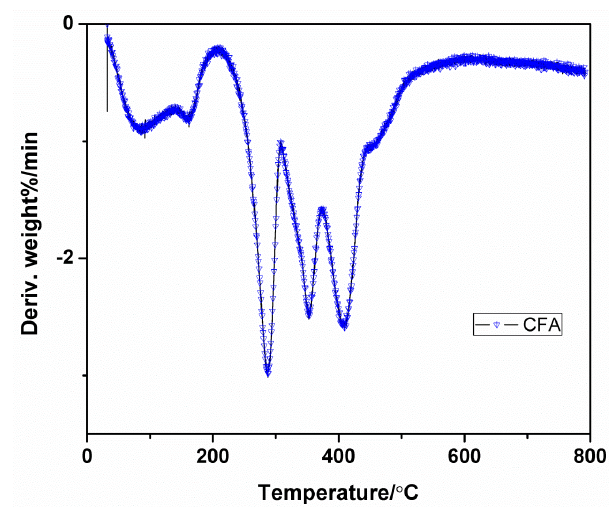
Figure 6. Di ff erential Thermal Analysis (DTG) curve of Figure 6 . Differential Thermal Analysis ( DTG) curve of CFA. Figure 6 . Differential Thermal Analysis ( DTG) curve of CFA.